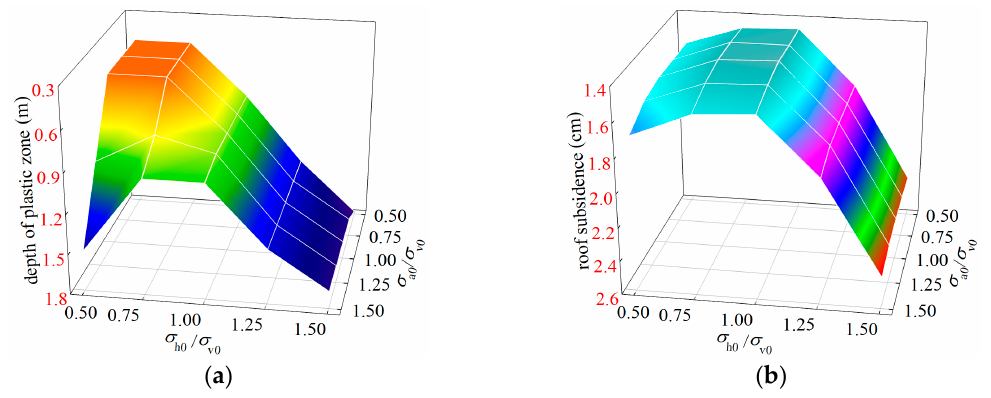
Figure 7. Results of the perfectly elastoplastic model: ( a ) roof plastic zone depth and ( b ) roof subsidence.